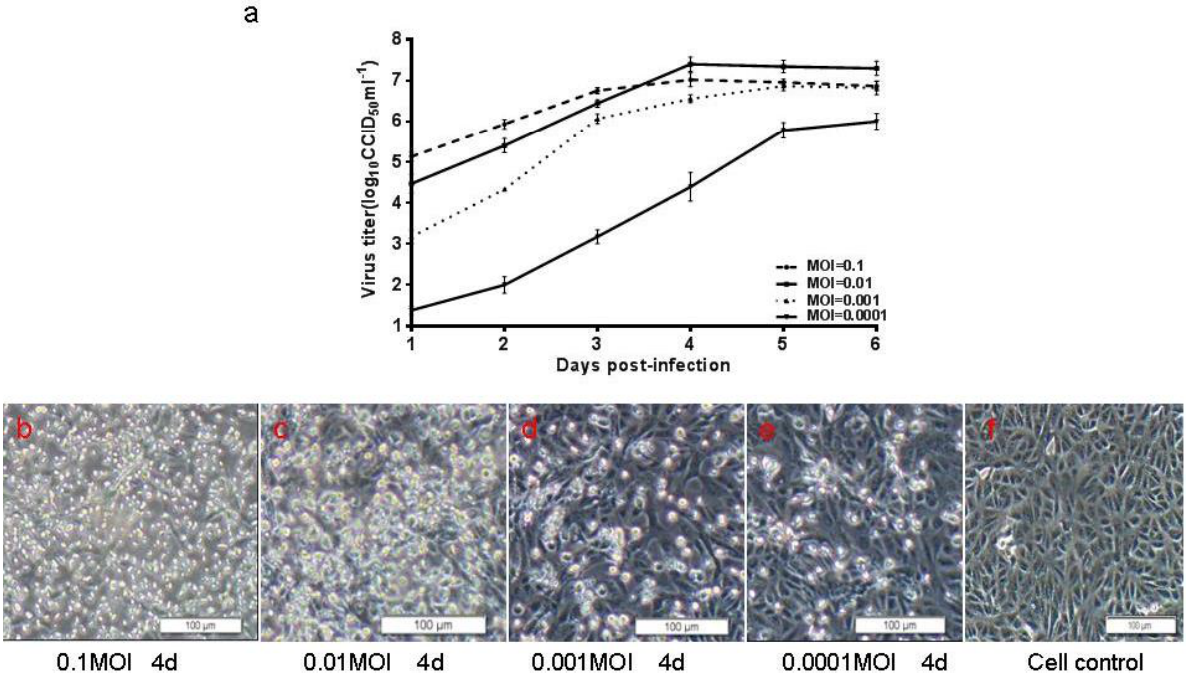
Figure 6. Growth kinetics of CC-16 strain and images of infected Vero cells. ( a ) Confluent Vero cells in cell factories were infected with CA16 at the MOI of 0.0001, 0.001, 0.01 and 0.1. The highest titer was 10 7.5 CCID 50 /mL achieved with the MOI of 0.01; ( b – f ) Images of Vero cells infected with CC-16 on the fourth day post-infection; ( g ) Image of control Vero cells. Bar = 100 µm.